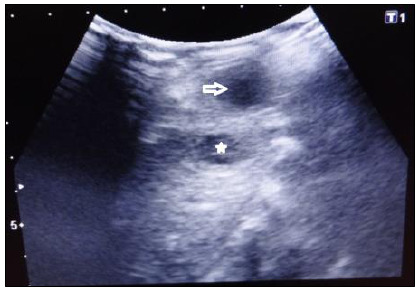
Figure 2: Case 1- USG showing hepatic abscess (asterisk) with extension to abdominal wall